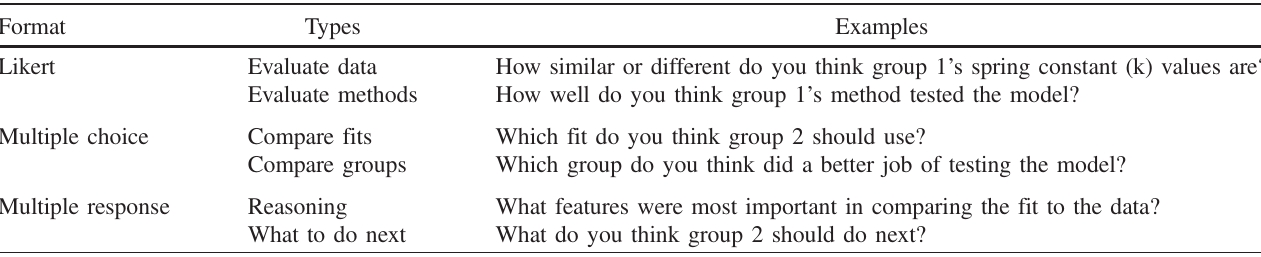
TABLE II. Question formats used on the PLIC along with the types and examples of questions for each format. Format